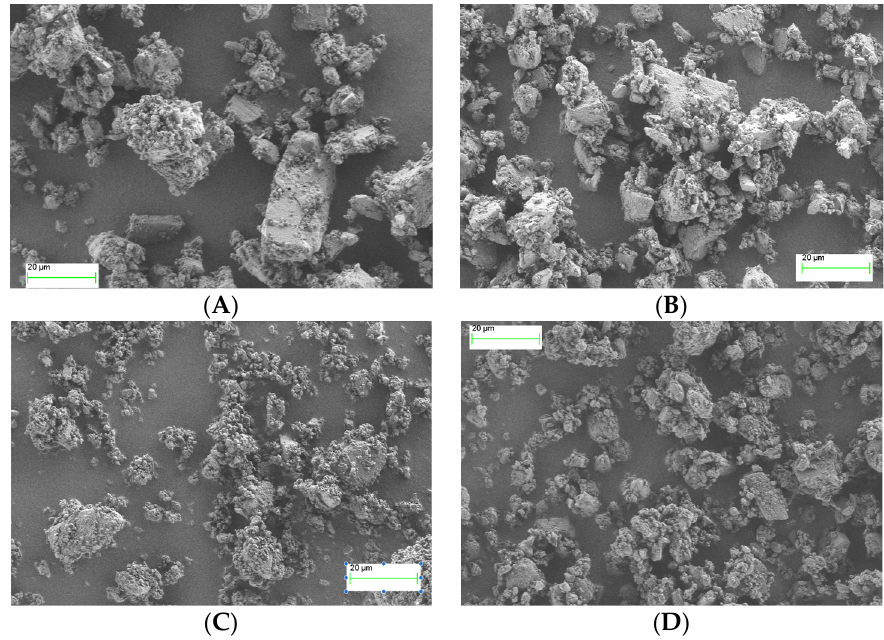
Figure 4. SEM pictures of samples of batch B1M1 ( A ), B2M1 ( B ), B3M2 ( C ), and B4M2 ( D ) taken at magnification 3000×.